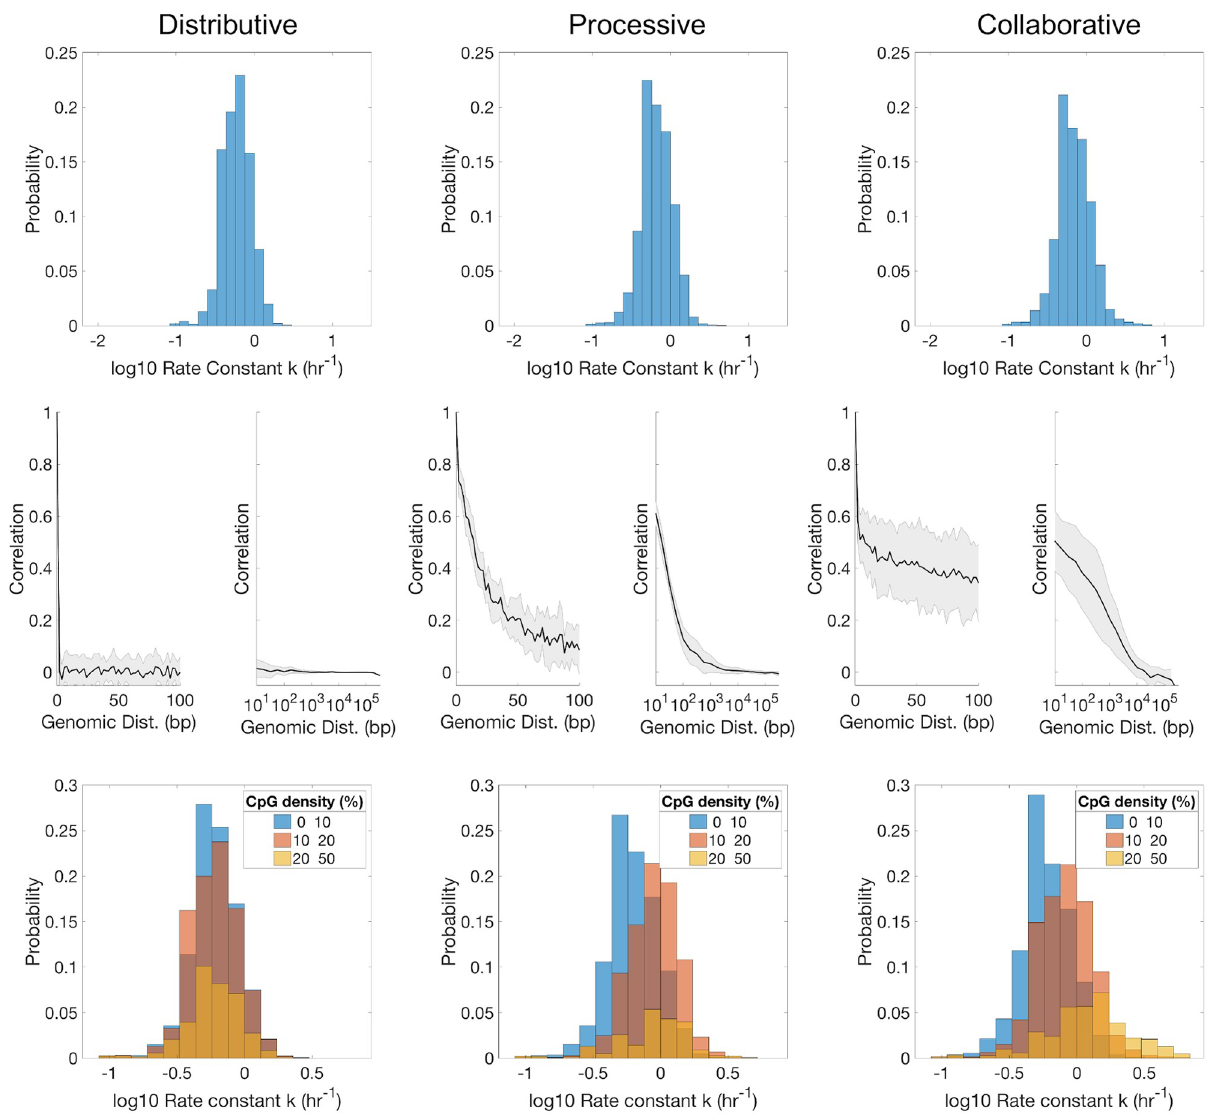
Fig 8. Simulated remethylation rate histograms (top), k -correlation with Genomic Distance (GD) (middle), and k -dependence on local CpG density (CpG d ) (bottom) when using each of the proposed mechanisms (Distributive, Processive, and Collaborative). The same in silico cluster containing 10 5 sites was used for all models. Both the position and the f for every site were sampled from an independent experimental dataset of a WGBS measurements from Chr1 in arrested HUES64 cells